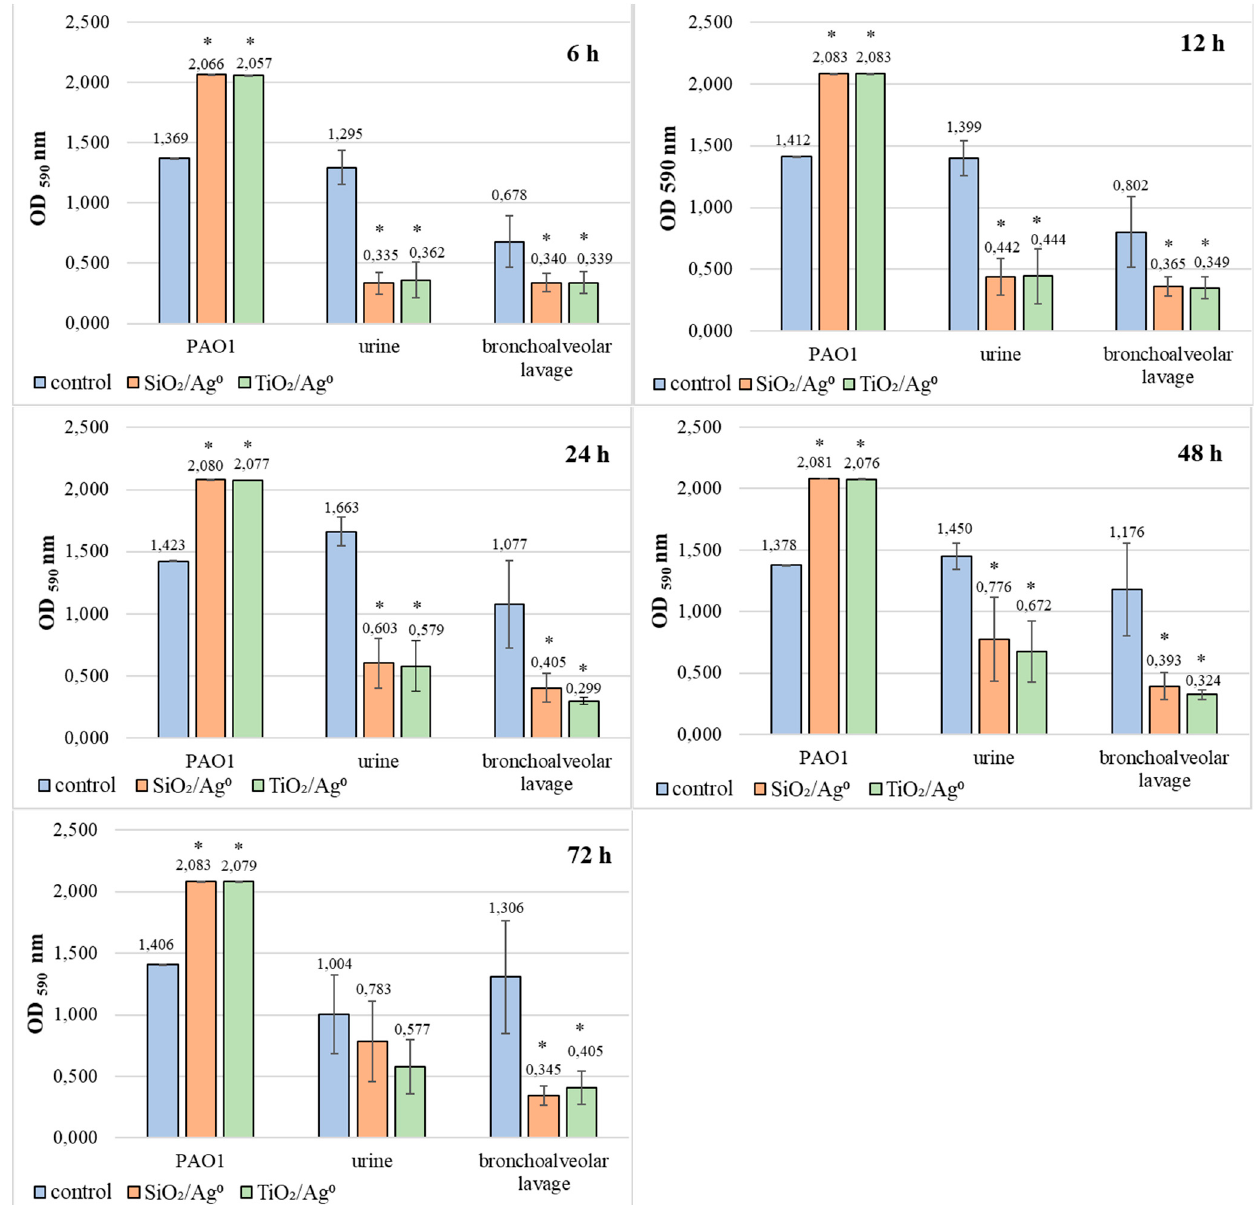
Figure 8. Effect of SiO 2 /Ag 0 and TiO 2 /Ag 0 at a concentration of 0.5 × MBIC on biofilm formation by PAO1 and clinical strains of P. aeruginosa . Values represent the mean ±SD for five strains isolated from urine and five from bronchoalveolar lavage fluid. * p ≤ 0.05 compared with control. Interpretation of the results: OD ≤ 0.096—non-biofilm producer; 0.096 < OD ≤ 0.192—weak-biofilm producer; 0.192 < OD ≤ 0.384—moderate-biofilm producer; OD > 0.384—strong-biofilm producer.